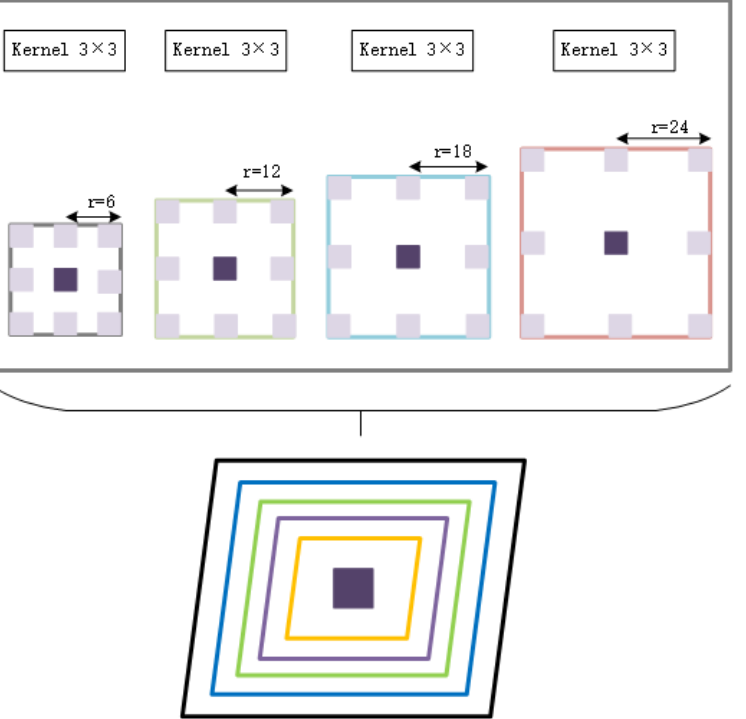
Figure 6. Atrous spatial pyramid structure.